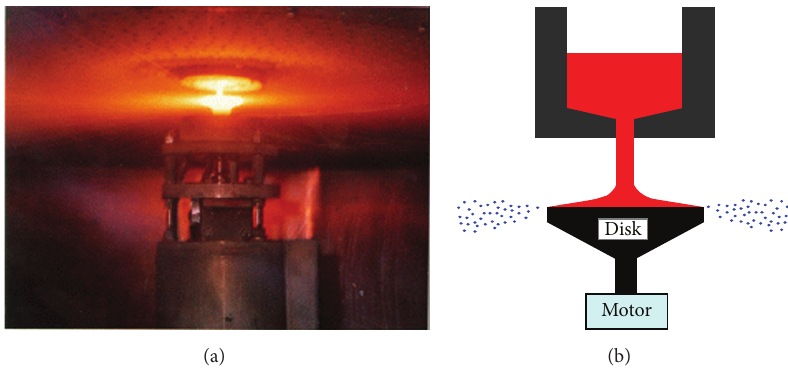
Figure 1: (a) Centrifugal atomization process and (b) schematic drawing of equipment.